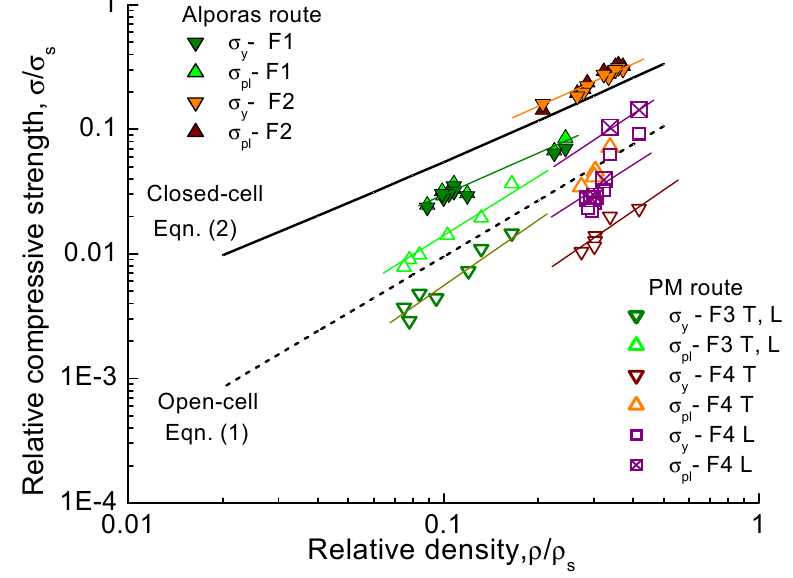
Figure 5. Relative compressive strength plotted against relative density for different kinds of Al-foams. Symbols L and T correspond respectively to longitudinal and transverse